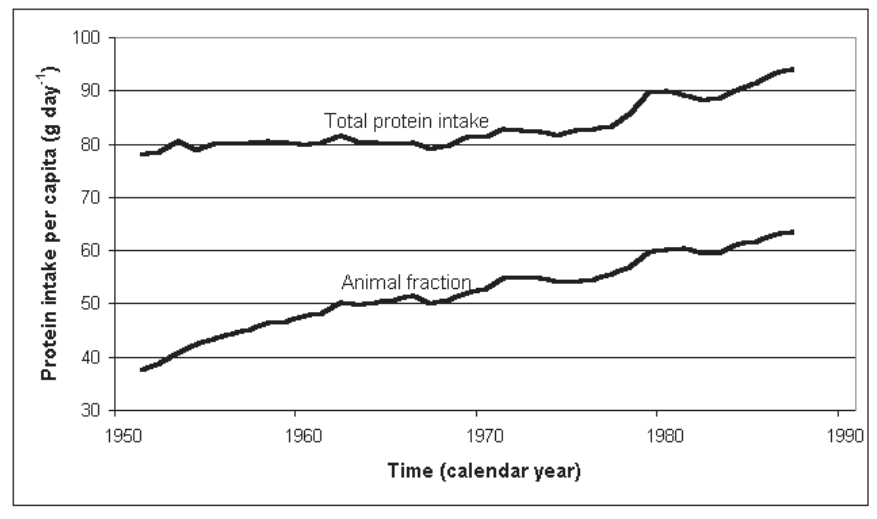
FIGURE 7. The daily total protein intake per capita in postwar Germany and the increase of the animal fraction in the course of